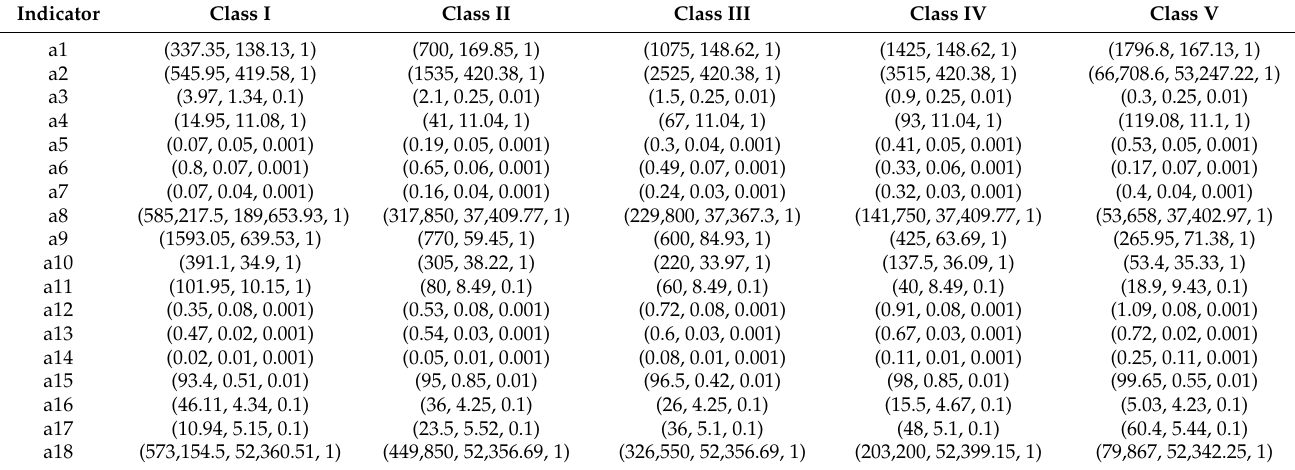
Table 3. Cloud eigenvalues corresponding to five assessment grades of evaluation